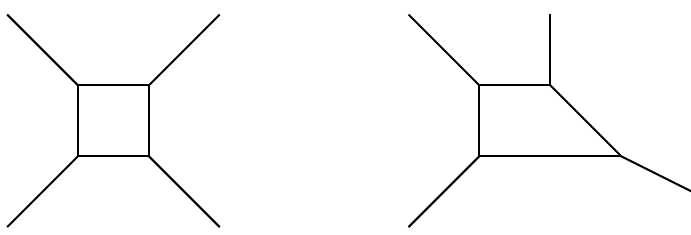
Figure 8. 5-brane web diagrams for pure SU(2) 0 (left) and pure SU(2) π (right) gauge